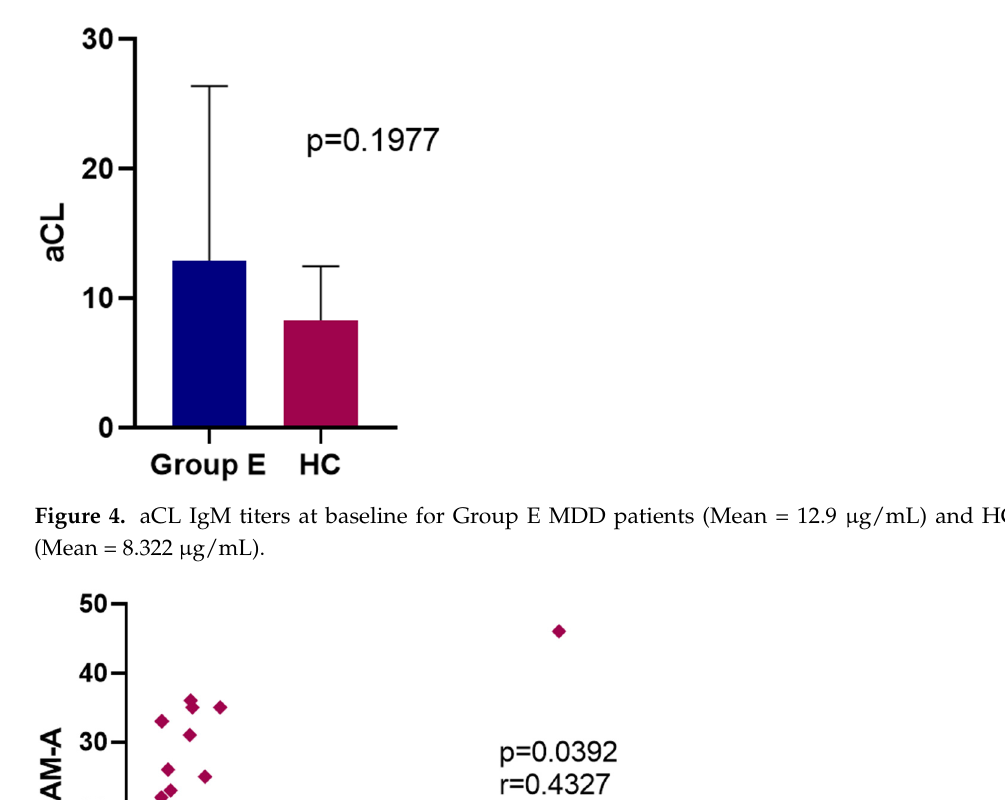
Figure 5. aCL IgM titers of Group E MDD patients in correlation with HAM-A baseline.